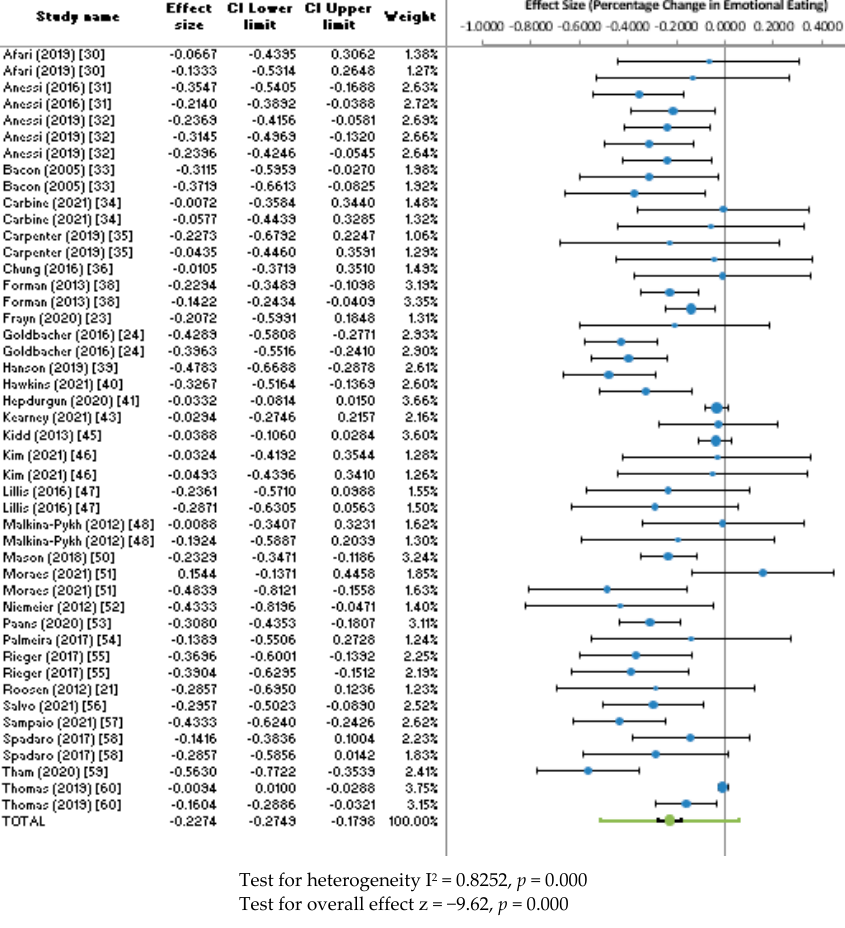
Figure 4. Forest plot for effect size of percentage change in emotional eating .